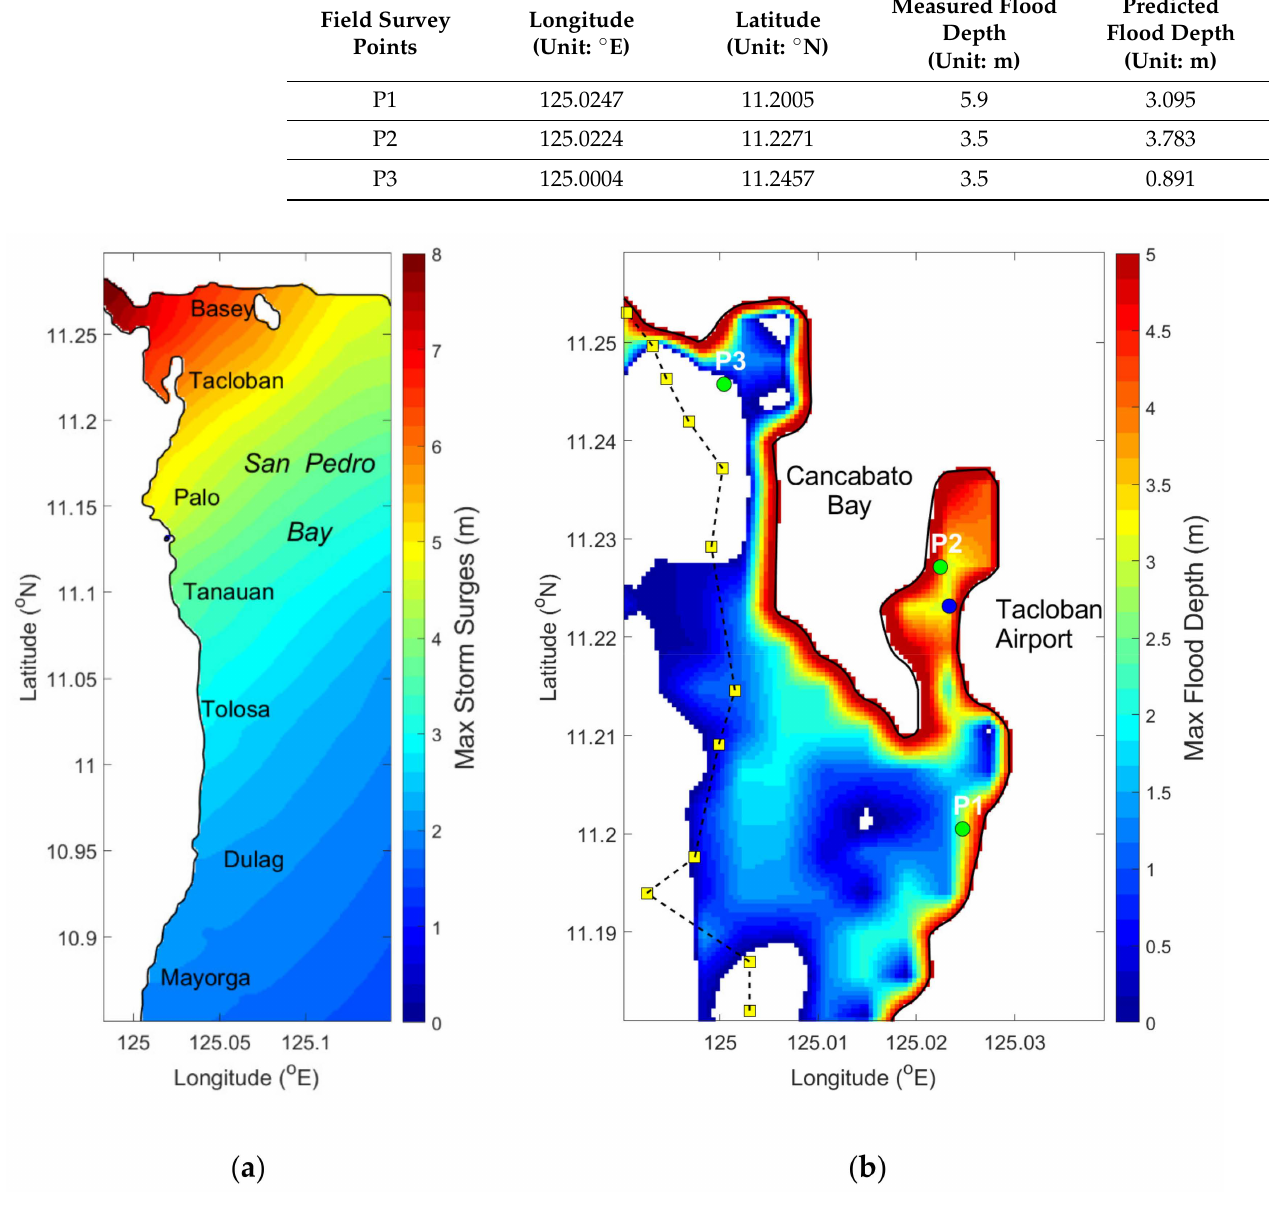
Figure 13. ( a ) Maximum storm surges of Domain D02. The color shading indicates the maximum storm surges in m. The solid black line indicates the coastline in the numerical model. ( b ) Maximum flood depth of Domain D03. The color shading indicates the maximum flood depth in m. The solid black line indicates the coastline in the numerical model. The blue circle shows the location of the Tacloban DZR Airport. The green circles imply the locations of measured flood depths (see Table 5). The yellow rectangles with the dashed black line mark inundation areas of